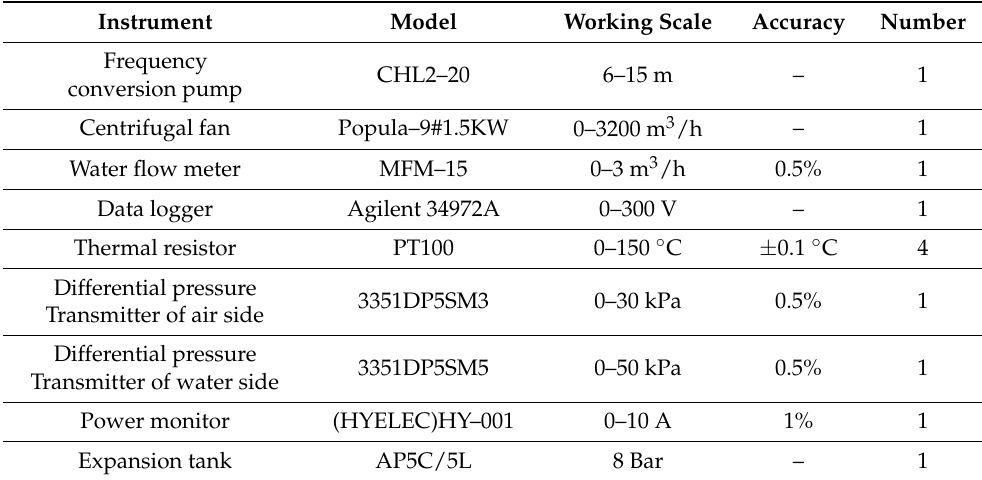
Table 2. Information of experimental